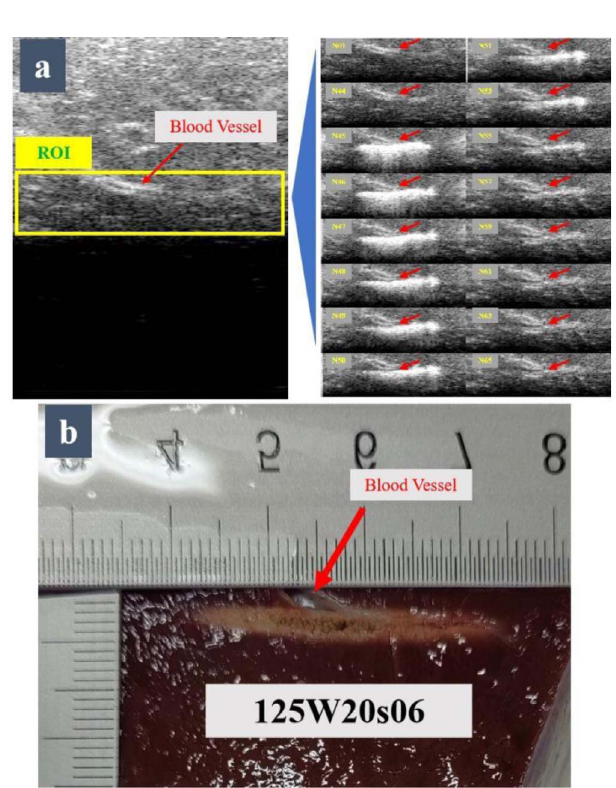
Figure 4. B-ultrasound image and damage slice in 125W20s case (a) B-ultrasound image, with red arrows pointing to such special tissue structure as blood vessels as spatial reference. (b) Damage